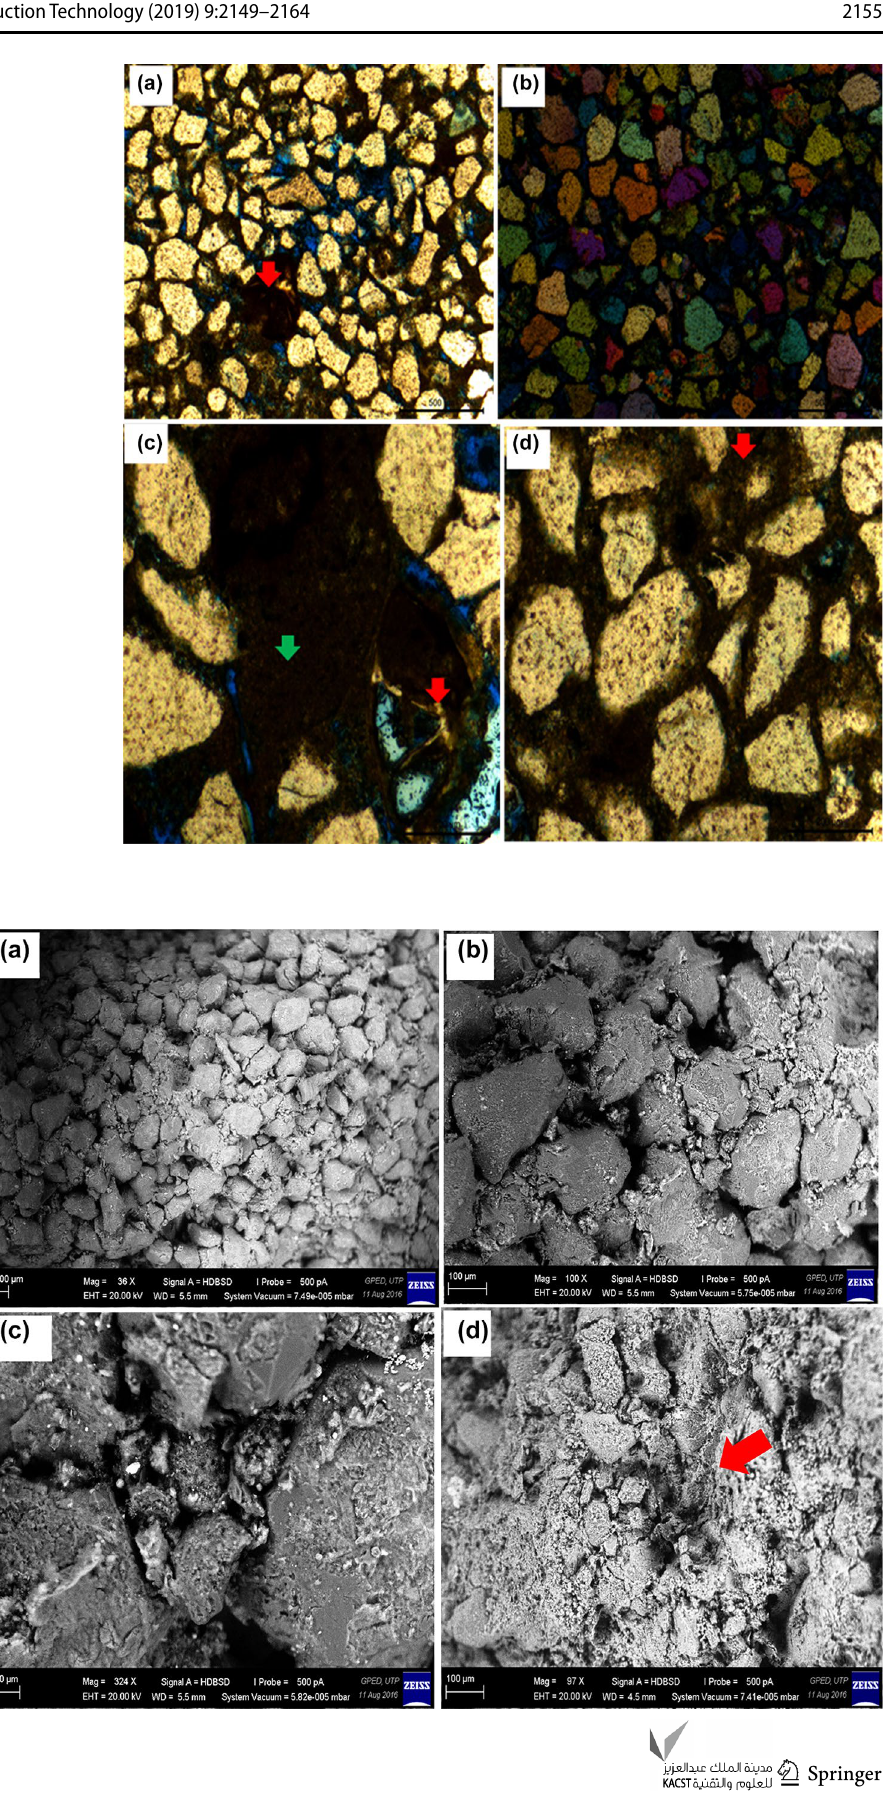
Fig. 6 Petrography of rock fabric variations. ( a ) Embedded fossil shell filled with matrix, ( b ) a XPL of opaque FeO, siderite and clay fractions, ( c ) matrix-filled intra-pore, ( d ) matrix infill of intergranular pore in MMGS (WB C14T9) lithofacies sandstone at depth 1770.78 m